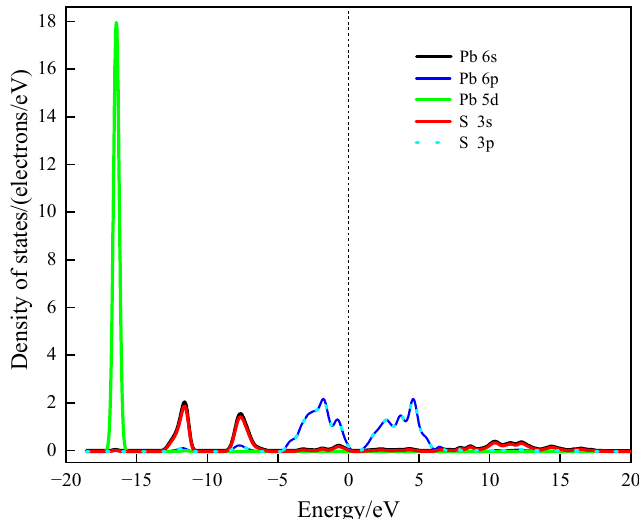
Figure 5. The density of states of perfect galena.